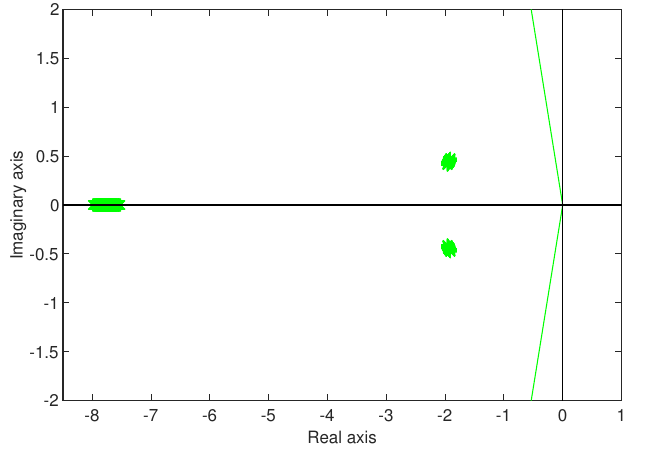
Figure 5. Eigenvalue perturbation region of system with order α = 7